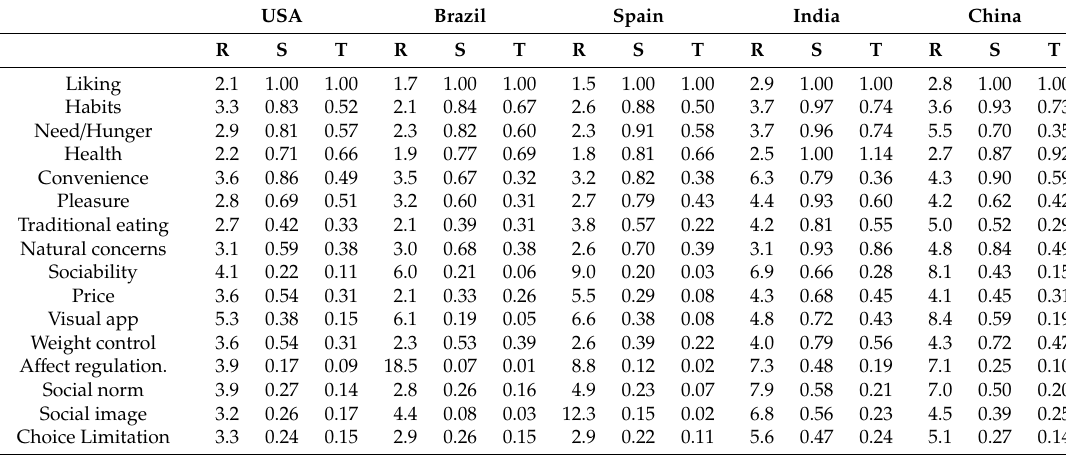
Table A5. Ratios of CAS “agree” responses to CATA “agree” responses and standard indices of importance for CAS and CATA “agree” responses for each motivation construct to the liking construct for fruits and vegetables in all five countries.